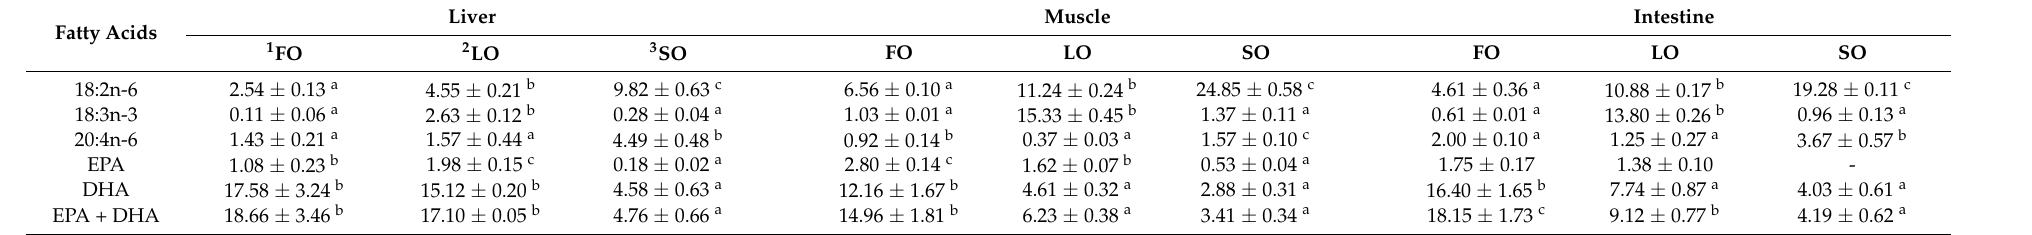
Table 2. The polyunsaturated fatty acid composition in liver, muscle, and intestine of rainbow trout (% total fatty acid methyl